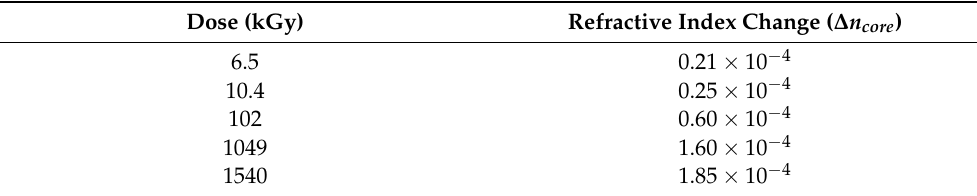
Table 1. Radiation-induced RI changes in a B/Ge codoped fiber reported by Kher et al. Adapted with permission from ref. [18]. Copyright 2013 IEEE.